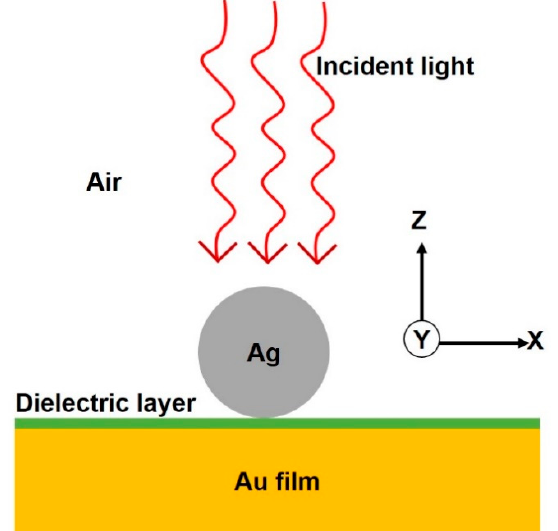
Figure 1. Schematic representation of a nanoparticle on a metallic mirror separated by a thin dielectric layer. Materials used in our design are as follows: gold film, a dielectric layer with index n = 1.5, and a silver nanoparticle.